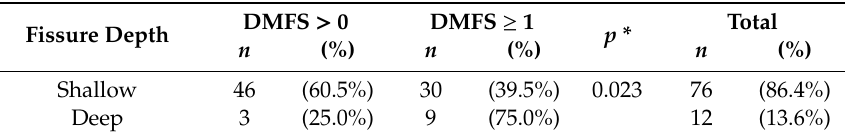
Table 3. Baseline fissure depth in the lower first permanent molars and dental caries prevalence during the final observation.